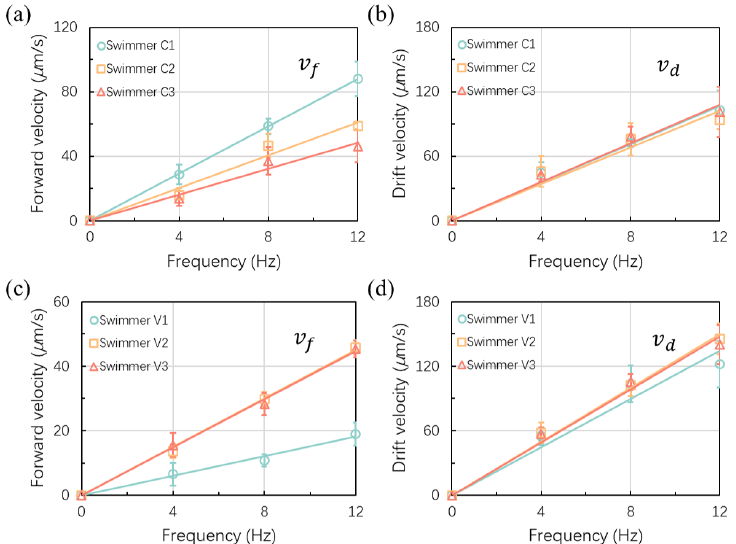
Figure 5. Swimming velocity of crescent-shaped and V-shaped microswimmers under the different frequencies of the rotational magnetic field. ( a ) The forward velocity of crescent-shaped microswim- mers; ( b ) Drift velocity of crescent-shaped microswimmer; (in ( a , b )): (cid:3) for microswimmer C1; (cid:52) for microswimmer C2; (cid:13) for microswimmer C3. ( c ) Forward velocity of V-shaped microswimmer; ( d ) Drift velocity of V-shaped microswimmers; (in ( c , d )): (cid:3) for microswimmer V1; (cid:52) for microswim- mer V2; (cid:13) for microswimmer